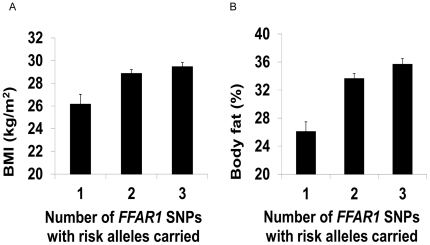
The cumulative effect of carrying risk alleles in three SNPs of FFAR1 on BMI and body fat.Data presented are mean ± SEM of BMI (Panel a) and body fat (Panel b) for individuals according to the number of SNPs for which risk alleles were present. Each SNP (rs2301151; rs1573611; rs16970264) was scored 0 or 1 based on the presence of risk alleles (dominant model). The presence of risk alleles for each SNP was summed. All individuals had at least 1 SNP with risk alleles present. There was a cumulative effect on BMI of 1.04±0.41 kg/m2 per SNP, P = 0.01 and of body fat (%) of 1.75±0.6% per SNP, P = 0.001 assessed by linear regression analysis with age and gender as covariates. The effects were statistically significant when accounting for multiple comparisons by the Benjamini and Hochberg False Discovery Rate procedure with q* = 0.05.